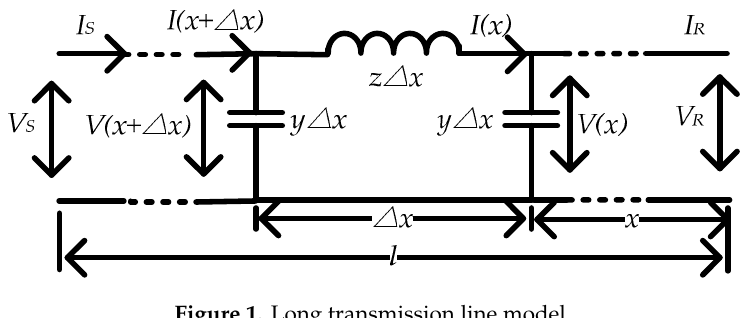
Figure 1. Long transmission line model .